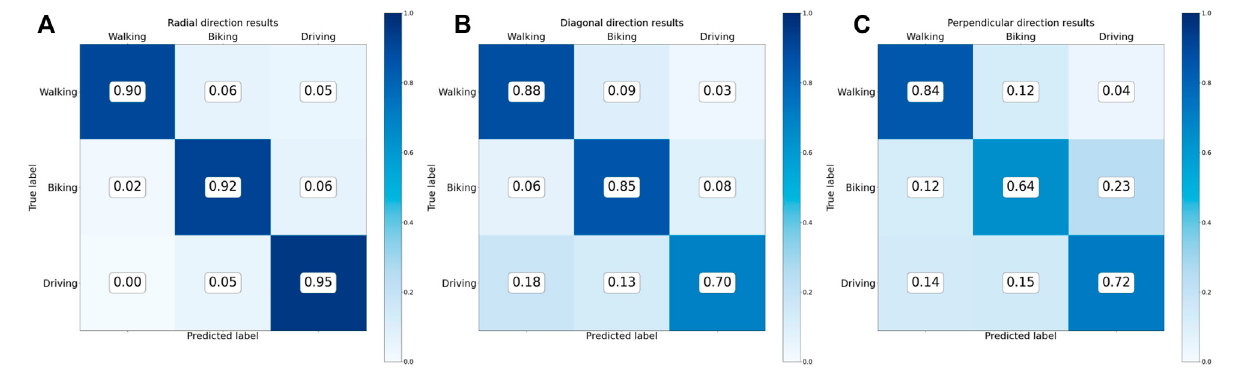
FIGURE 16 | Confusion matrices for radial (A) , diagonal (B) , and perpendicular (C)